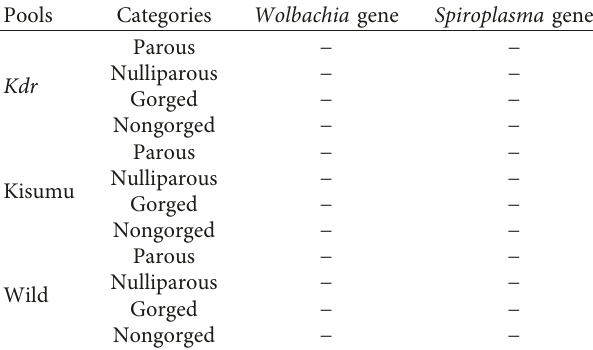
Table 6: Search for Wolbachia ssp and Spiroplama ssp genes. Pools Categories